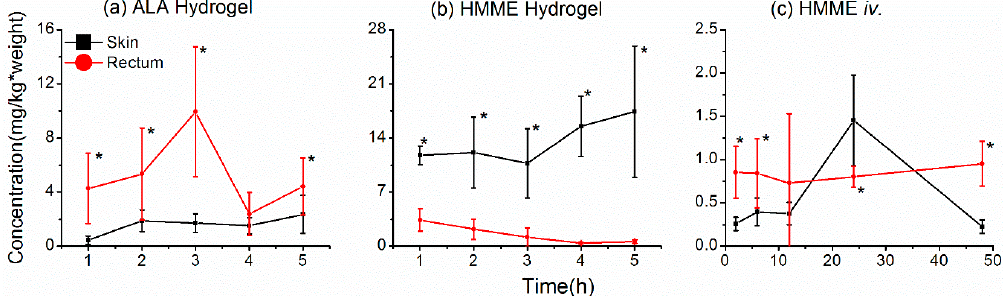
Figure 3. Uptake of photosensitizers into the rectal wall and skin. ( a , b ) Levels of 5-aminolevulinic acid (ALA) ( a ) or hematoporphyrin monomethyl ether (HMME) ( b ) were measured in the skin or rectum after cutaneous or intrarectal administration of a hydrogel, respectively; ( c ) levels of HMME were measured in the skin and rectum after intravenous injection. Photosensitizer concentrations are represented as mg/kg of tissue. The asterisks * mean significant difference ( p < 0.05) between the two tissues at the same time point.